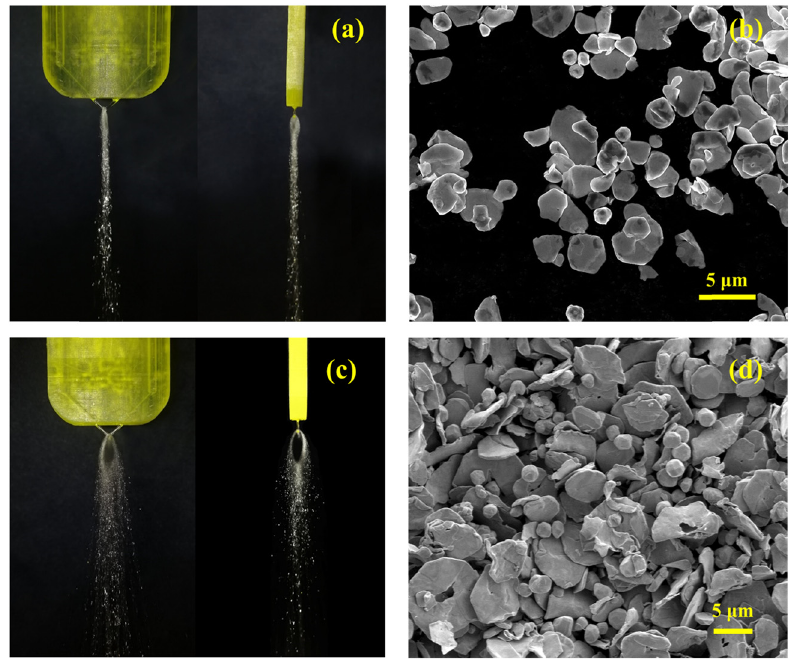
Figure 2: Images of the micro - jet fl ow and SEM of the prepared silver powder: ( a ) a front view and side view at 50 mL · min − 1 ; ( b ) prepared silver powder at 50 mL · min − 1 ; ( c ) a front view and side view at 70 mL · min − 1 ; ( d ) prepared silver powder at 70 mL · min − 1